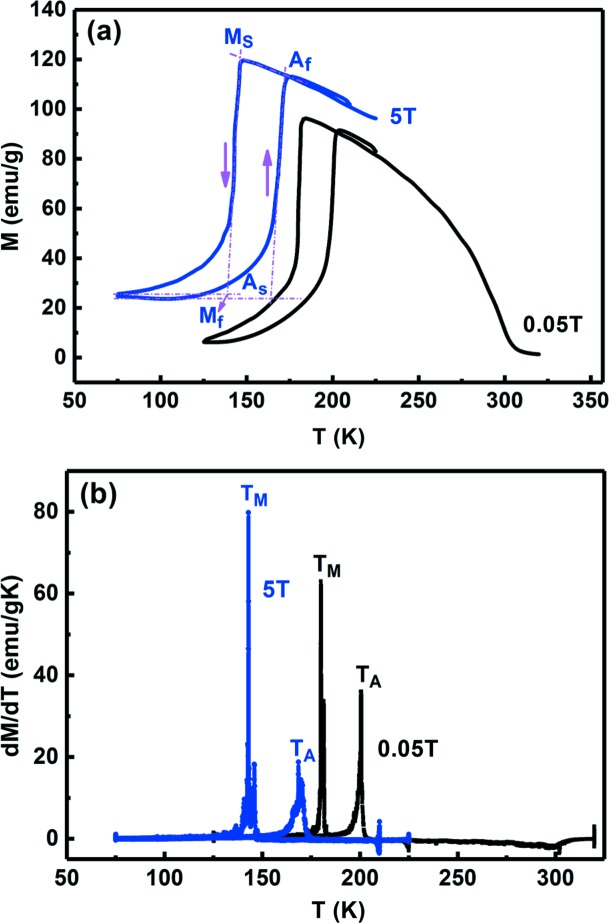
(a) M(T) curves measured under magnetic fields of 0.05 and 5 T for the Ni43.7Cu1.5Co5.1Mn36.7In13 microwire. The determination of phase transition temperatures is illustrated in the figure. (b) The temperature dependence of dM/dT derived from the M(T) curves in panel (a).